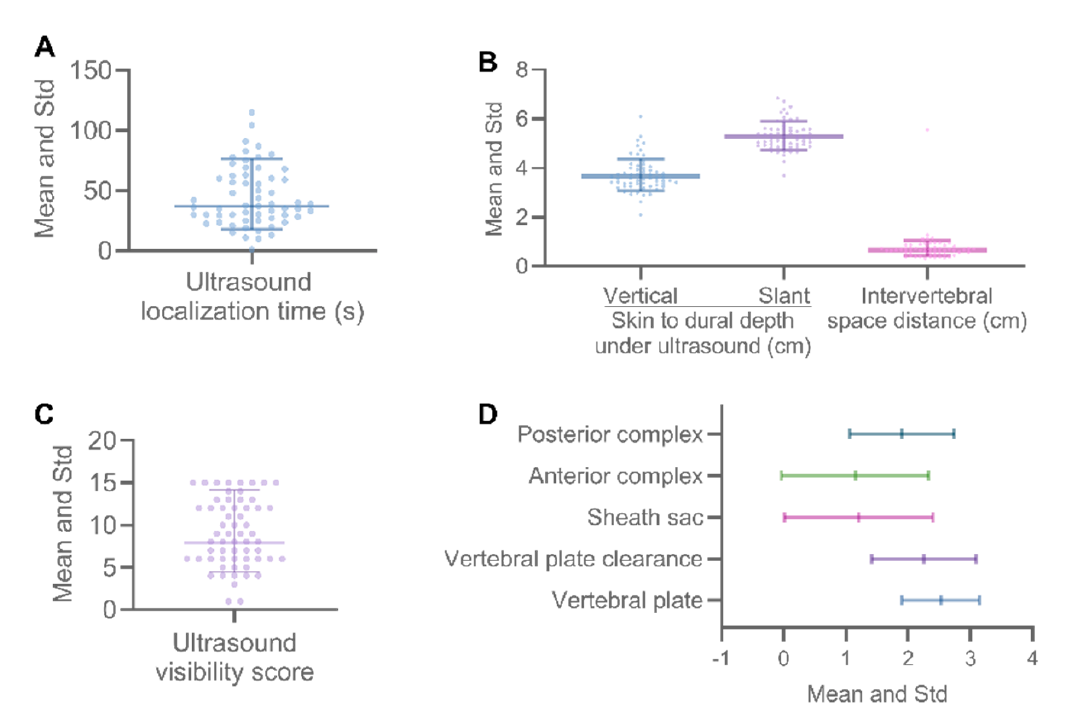
Table 2. Ultrasound Visibility Score of Neuraxial Structures. 0 Point